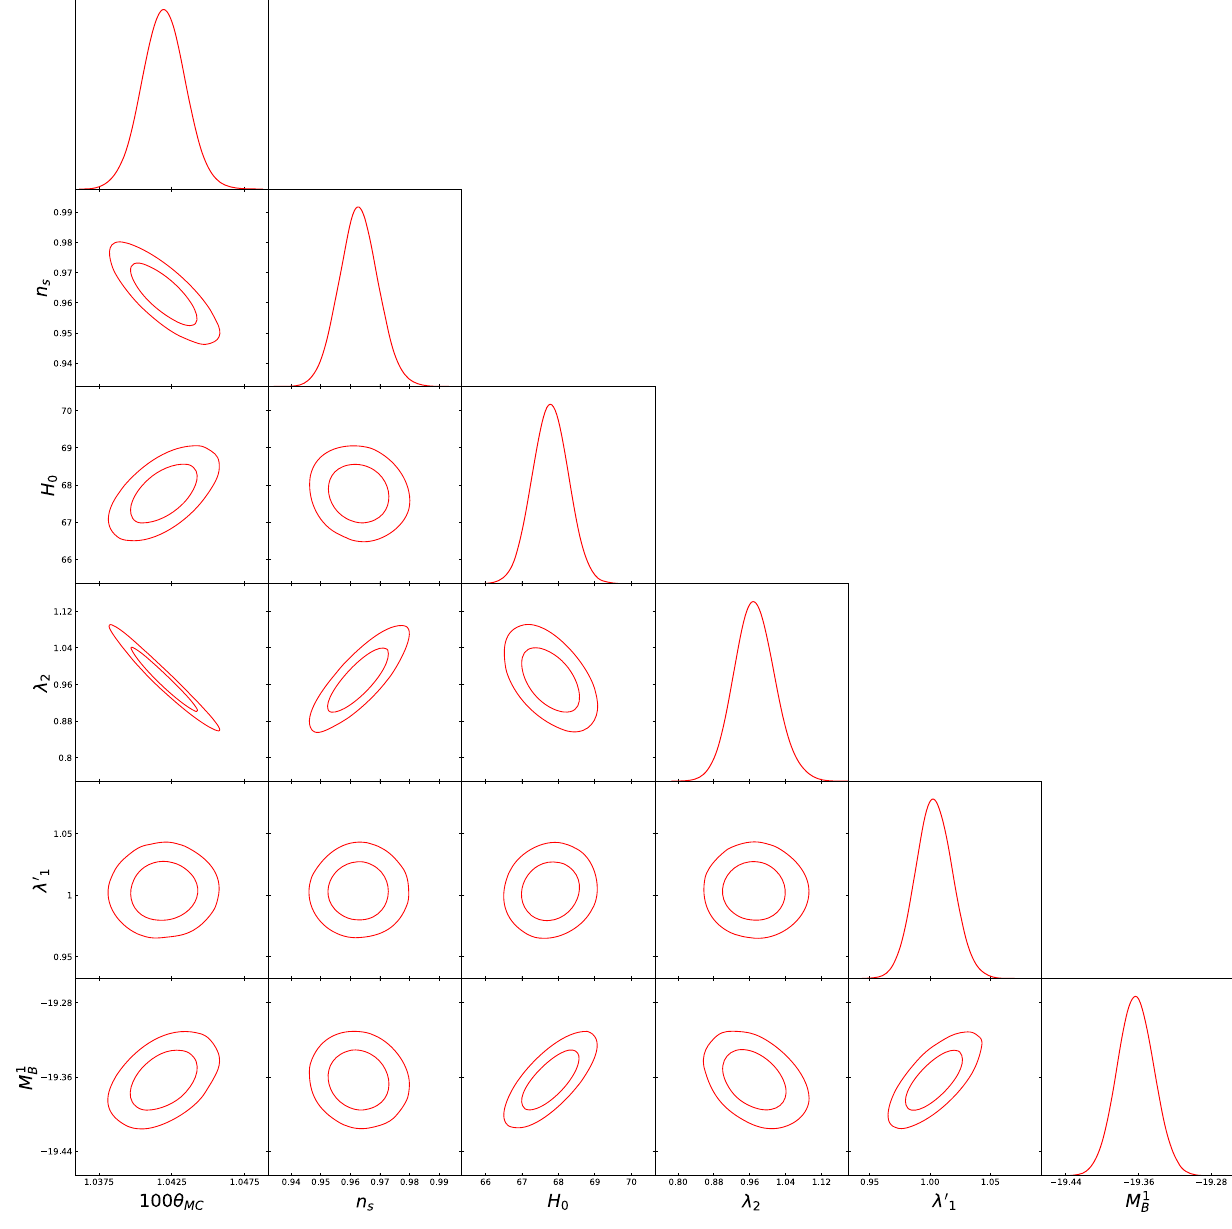
Fig. 2 The constraints on λ (cid:7) , λ 2 and M 1 from the data combination of CMB, BAO and SNIa. Also we present the constraints on n s H 0 and θ MC B 1 which are affected most by the former three